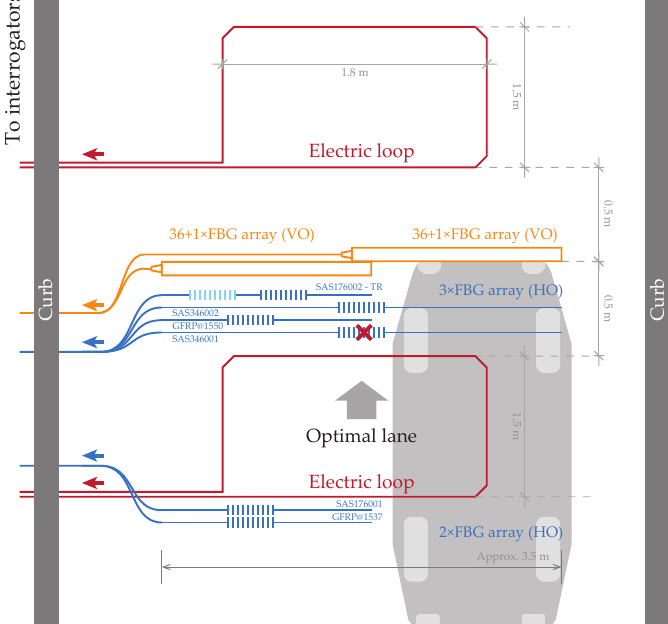
Figure 1. Real test platform scheme with multiple Fiber Bragg Grating (FBG) sensors. Some are connected as an FBG sensor array. The red cross indicates a dysfunctional FBG sensor (destroyed when the test platform was created). This test platform was built on the road into the university